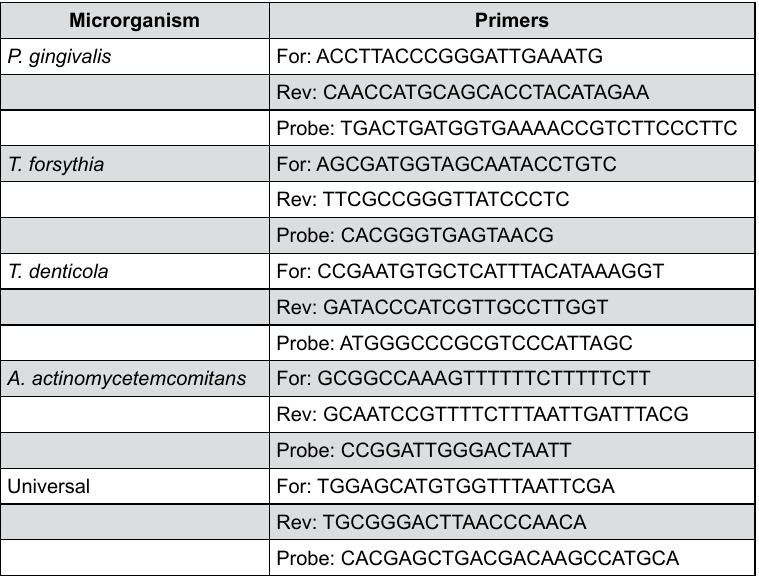
Figure 1- Specific primers and probes used in the